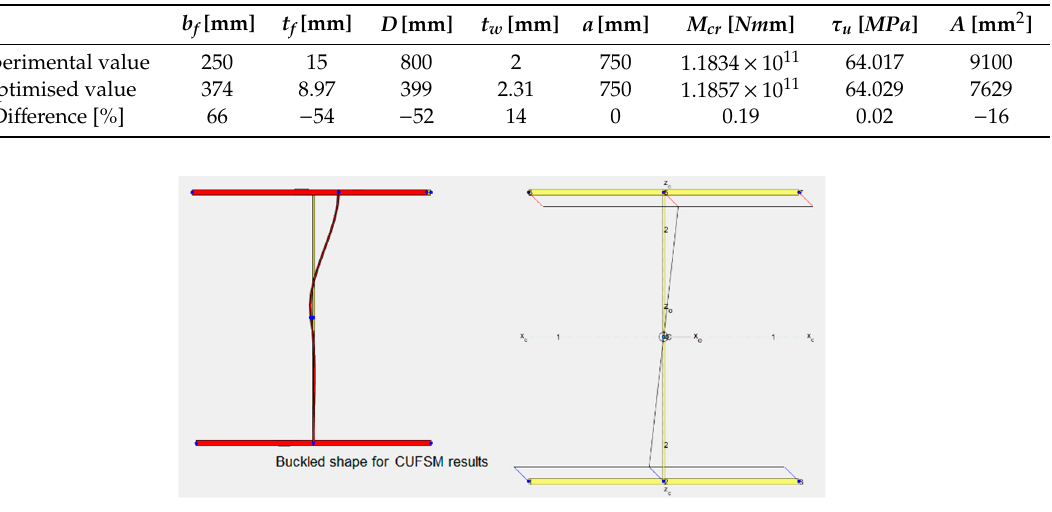
Figure 8. Results of the analysis with finite strip method using the software package CUFSM for the noncompact web.